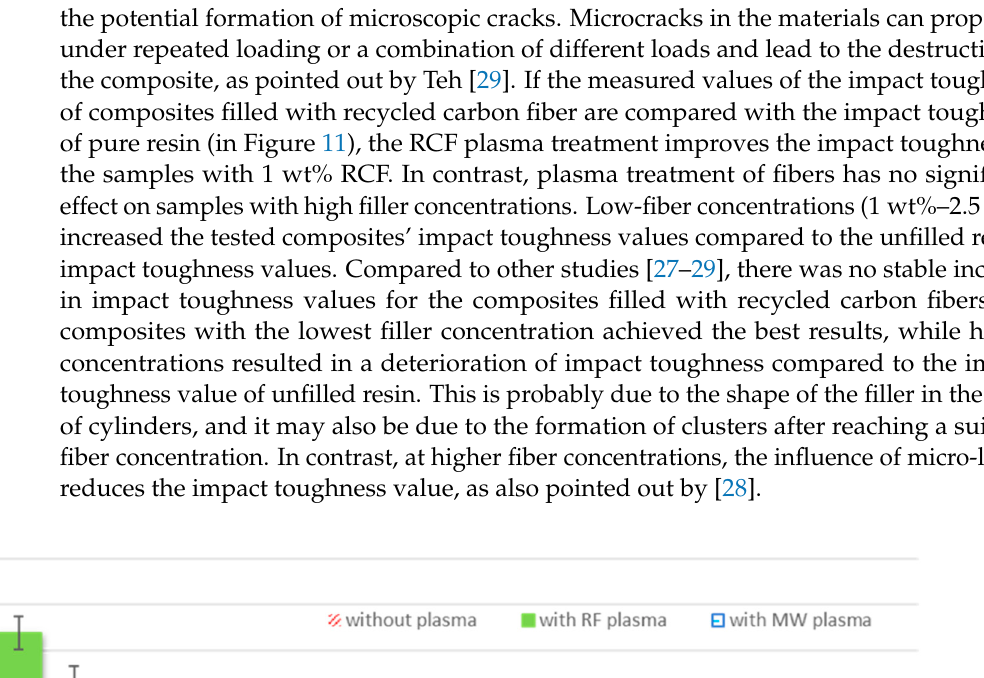
Figure 11. The impact toughness of FRE composites. Three-point bending. The three-point bending results are shown in Figure 12. Flex- ural strength is the ability of material to resist a bending force applied perpendicular to the longitudinal axis of the composite specimen. The stress induced by the bending load is then a combination of compressive and tensile stresses [29]. Figure 12 compares the tested composite specimen elastic modulus and bending stress values. It can be seen that the addition of fibers to the resin improves the elastic modulus and bending stress for all fiber concentrations and types. The effect of plasma treatments is negligible except at the lowest concentrations. At low concentrations of 1 wt%, an increase in elastic modulus is observed, namely by 10% for samples with RCF fibers without plasma treatment, by 29% for samples with RCF with RF plasma treatment, and 21% for samples with RCF with MW plasma treatment. The improvement in bending stress values at the same concentration was 15% for samples with RCF without plasma treatment, 31% for samples with RCF with RF plasma treatment, and 26% for samples with RCF with MW plasma treatment. The scatter of the elastic modulus and bending stress values is lower for samples with fibers treated with both types of plasma treatments than for samples with untreated fibers. In this study, the samples are prepared using magnetic and manual mixing, which can be a problem at higher-fiber concentrations and can lead to increased fiber agglomeration and, indirectly, higher values of flexural